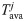
Reduction method employed in the analysis of the network activity.Method used to obtain a smaller network, which resembled the same features of activation probability density function FS as those of the original. (A) Example of the network density activity ρ during the jth avalanche. The time window Tavaj starts at approximately 13 ms. (B) Simplified representation of the reduction method. The first step was the arrangement of the element activities during an avalanche in a matrix of size N×Tavaj (step i), followed by ordering the elements according to their activity (step ii). The dimension of the matrix was reduced by a factor of c = 1250, grouping sequential elements (step iii), and each new element was considered active if at least 2 of its components was activated (step iv). Then, the probability of activation of each element was calculated by time, pait (step v), and finally the mean from nava = 10 000 avalanches, 〈pait〉nava, was calculated (step vi).